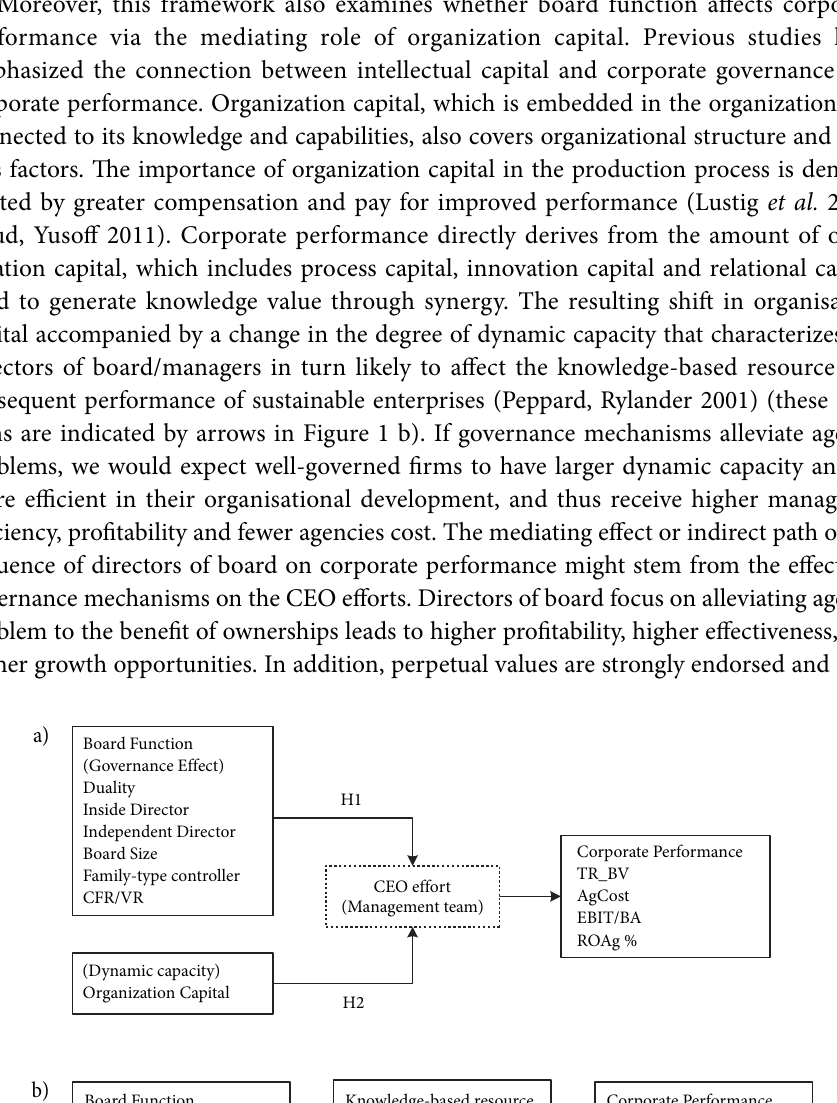
Fig. 1. a – direct path among of board function, organization capital and corporate performance; b – mediated effect between board function with corporate performance through organization capital